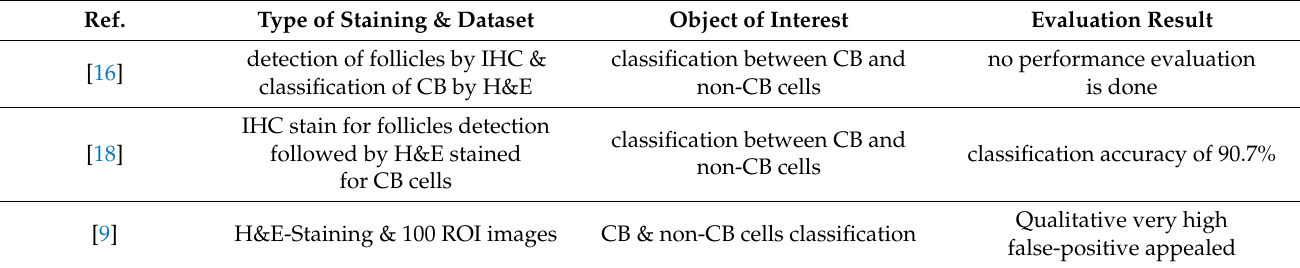
Table 3. Quantitative evaluation of past